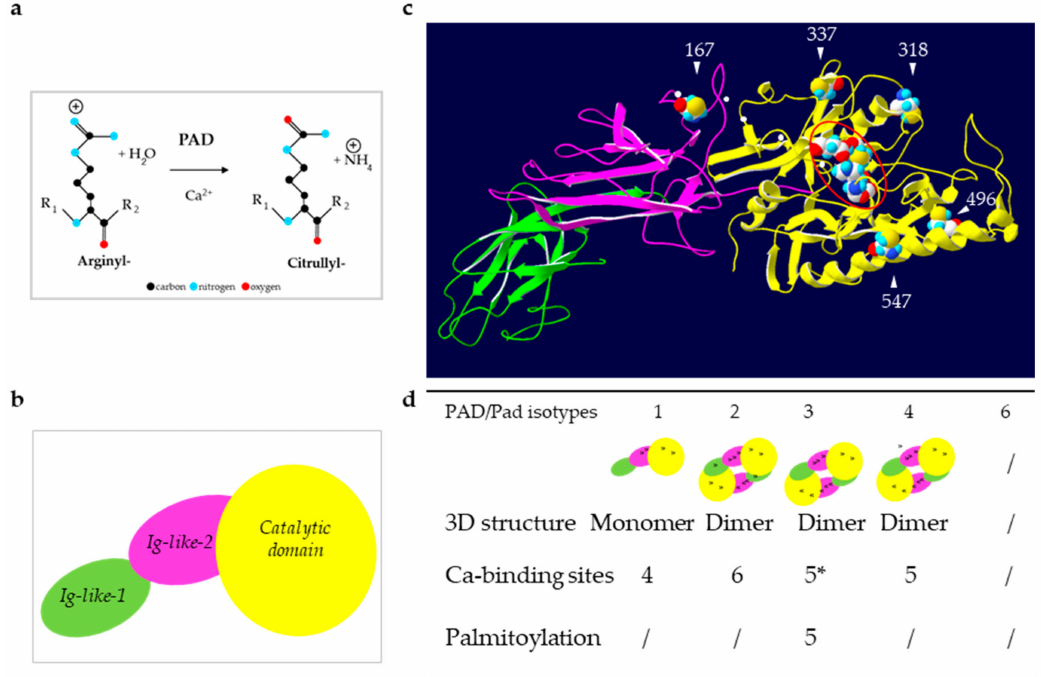
Figure 1. Reaction of deimination and structure of PADs. ( a ) Schematic representation of the reaction catalyzed by PADs: Deimination or citrullination. ( b ) Schematic representation of the sub-domains of PADs. ( c ) Illustration of an in silico three-dimensional (3D) model of the active PAD3. The white arrowheads indicate the five putatively palmitoylated cysteines (by similarities to mouse Pad3). The small white dots indicate the five conserved calcium binding sites. The four gathered major amino-acids of the active site are highlighted by a red oval (Asp350, His470, Asp472 and Cys646 by similarities to PAD4). ( d ) Summary of the structural data for each human (PAD) and mouse (mPad) isotypes. Positions of the calcium binding sites are indicated by black dots on each sub-domain representation. * As observed after a multiple sequence alignment (MultAlin), the amino-acids involved in the five calcium binding sites are highly conserved, especially between PAD4 and PAD3 [13]. / means that the information is not